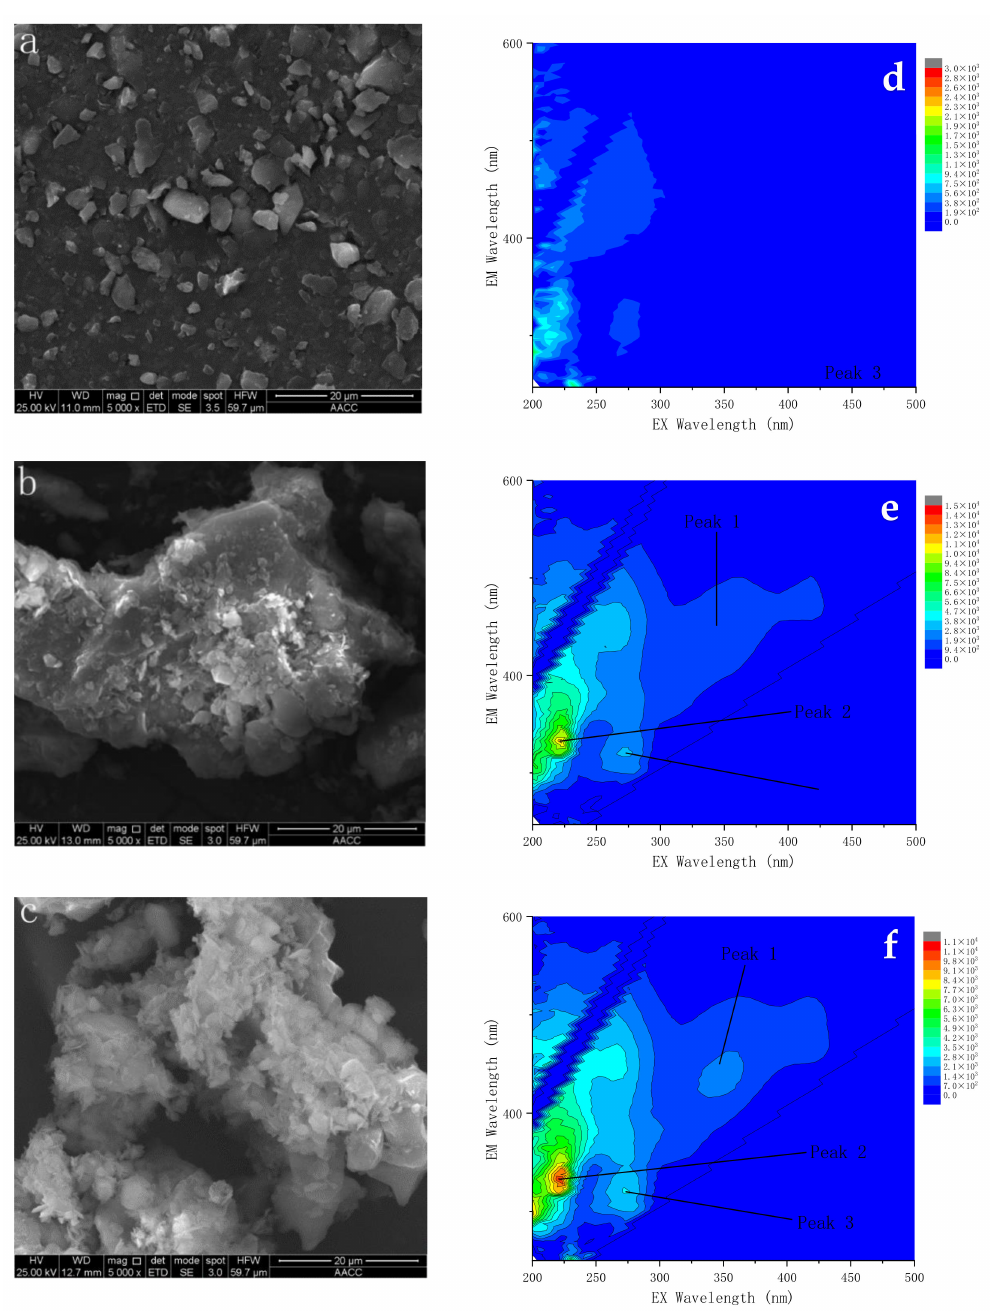
Figure 4. SEM images of ( a ) sterilized soil, ( b ) natural soil, and ( c ) natural soil + MZJ_21. Three- dimensional fluorescence monitoring of TB-EPS in consortium and mud systems: ( d ) natural soil, ( e ) consortium, and ( f ) natural soil + MZJ_21.3.4. Diversity of the Bacterial Community. Based on the number of OTUs, Table 2 lists the microbial diversity indexes in reactor added with the MZJ_21, natural soil, and natural soil + MZJ_21 after 48 h of reaction. The microbial diversity indicators include sobs, Shannon, Simpson, ACE, Chao, and coverage. The value of the sobs index is directly related to the number of OTUs obtained by sequencing. Shannon and Simpson index jointly reflect the species diversity of the sample, while ACE and Chao index jointly reflect the abun- dance of the sample species. The sequencing results show a high coverage of OTUs in the three samples, which is higher than 98.9%. This means that the results of microbial diversity can reflect the real composition of microorganisms in the